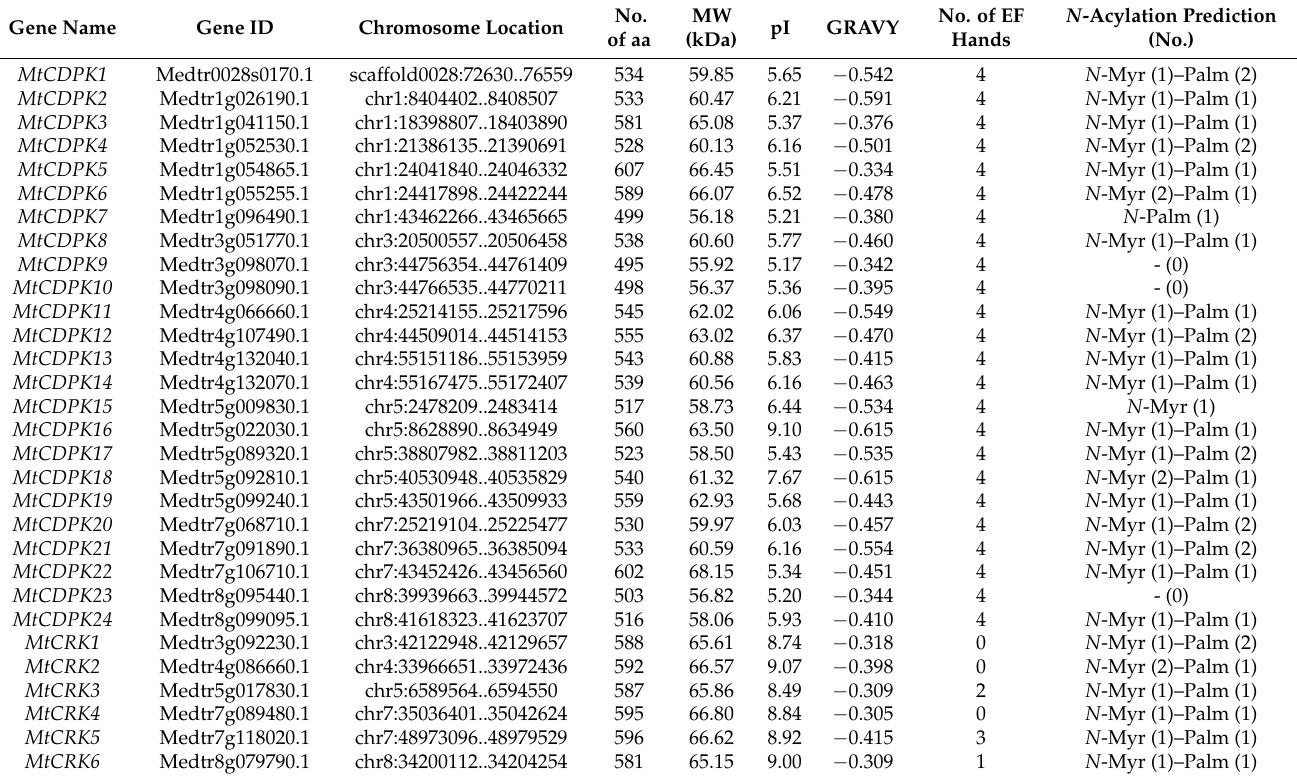
Table 1. Characteristics of CDPK and CRK genes in Medicago